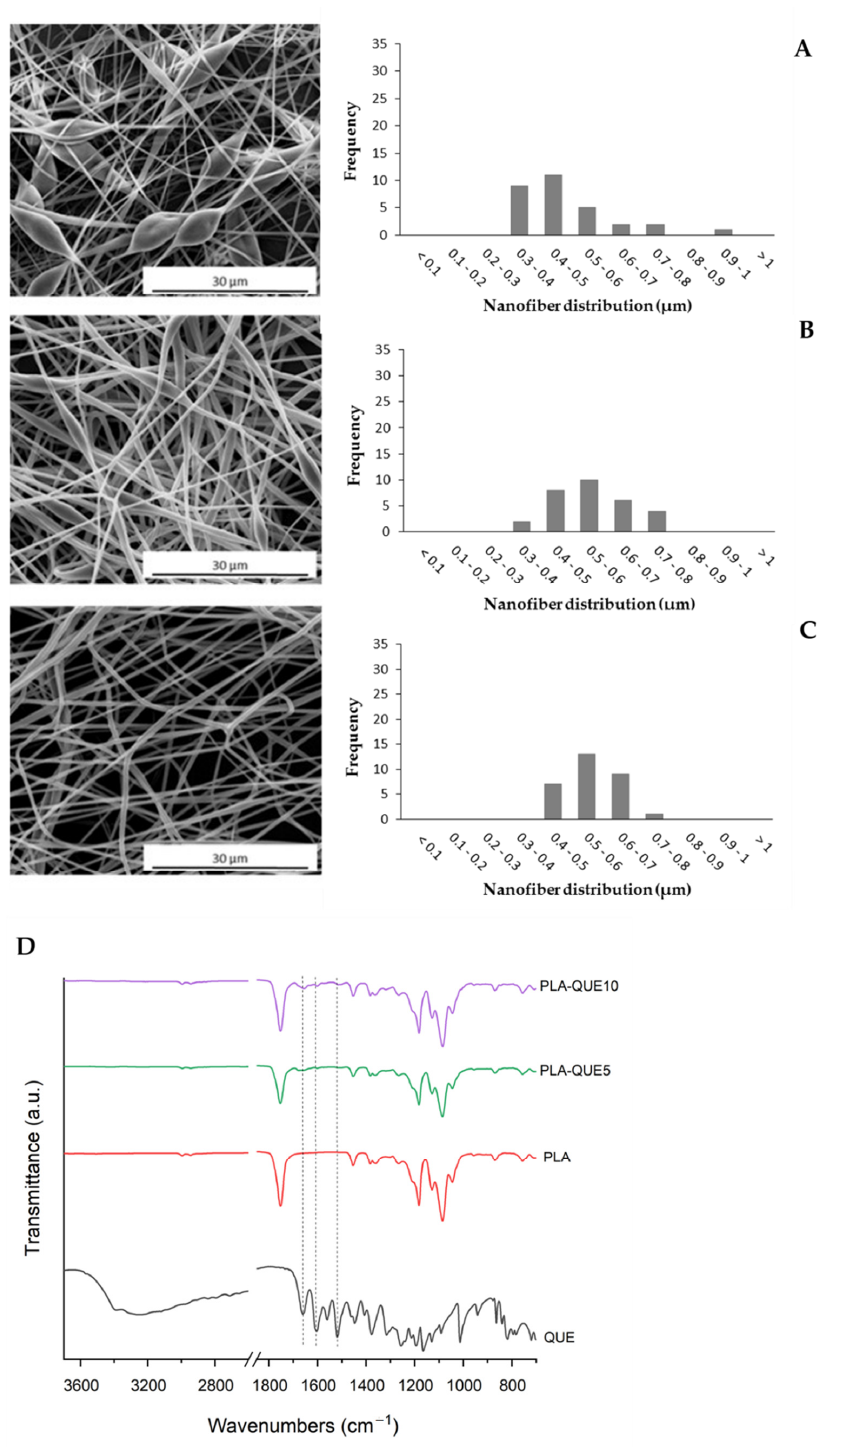
Figure 1. SEM micrographs ( left ) and size-distribution ( right ) of fibers prepared from polylactic acid (PLA) solutions containing various amounts of quercetin (QUE): ( A ) PLA, ( B ) PLA-QUE 5 and ( C ) PLA-QUE 10 . ( D ) FTIR-ATR spectra of QUE, neat PLA, PLA-QUE 5 and PLA-QUE 10 fibers.